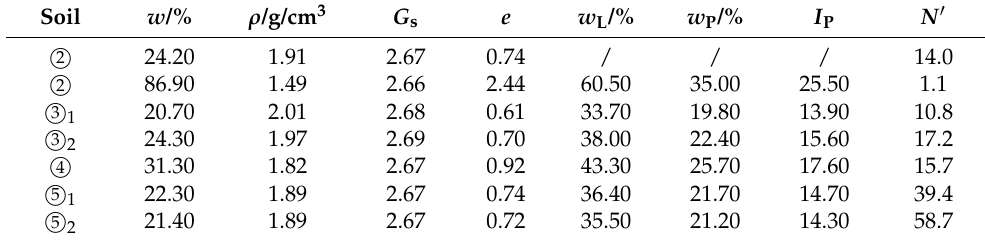
Table 1. Physical and mechanical properties of the soil.